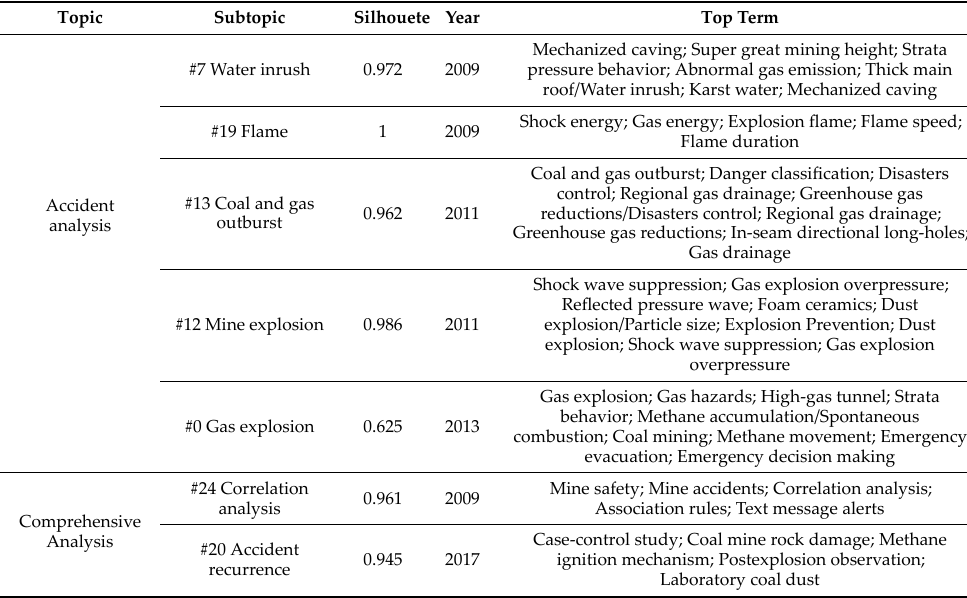
Table 5. Topic and top term of Coal Mine Disaster